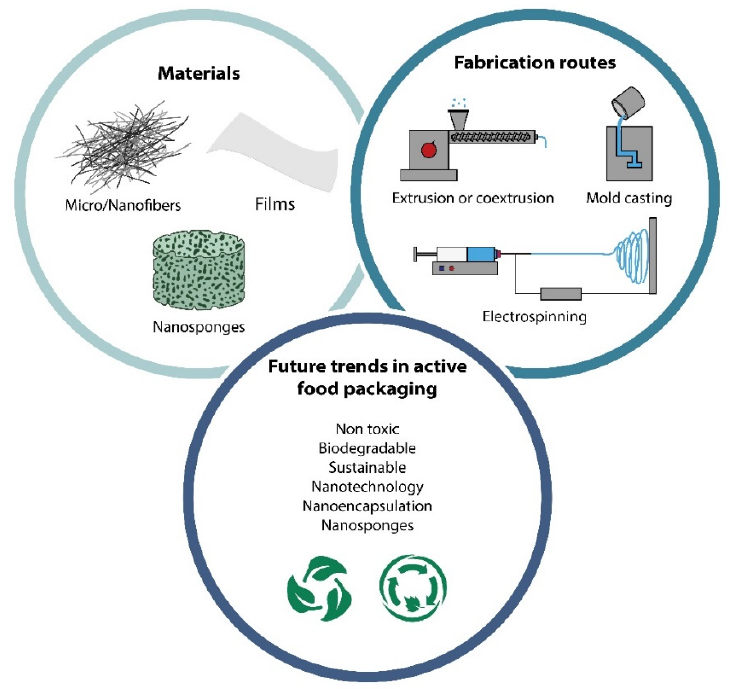
Figure 6. Cyclodextrins and polymers in active food packaging applications: materials and routes for incorporating CDs in polymers.